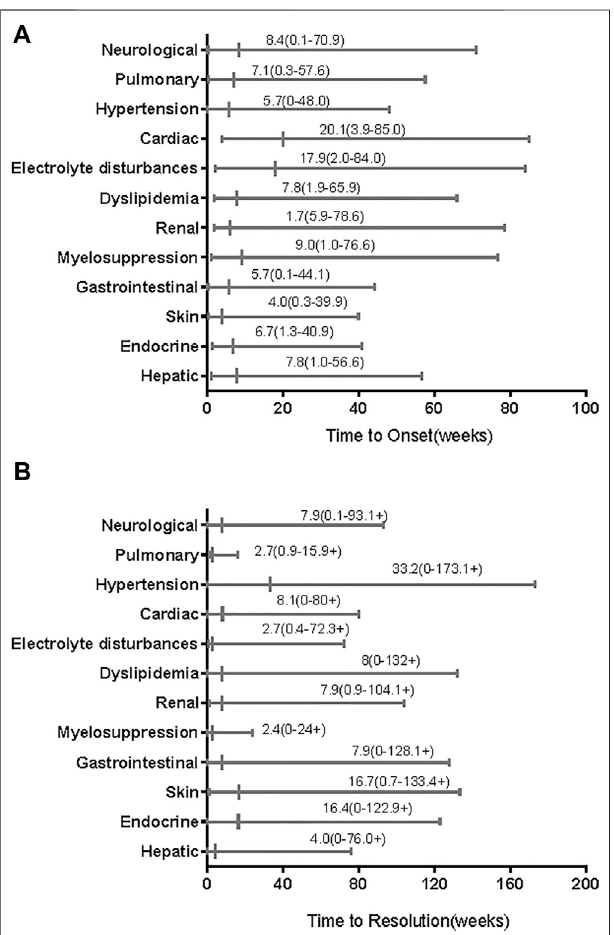
FIGURE 1 | Time to onset and resolution of treatment-related adverse events (TRAEs) of any grade. The small vertical lines represent medians and thebarsindicateranges. (A) Timetoonset; (B) timetoresolution.Thesymbols “ + ” in ranges indicate censored